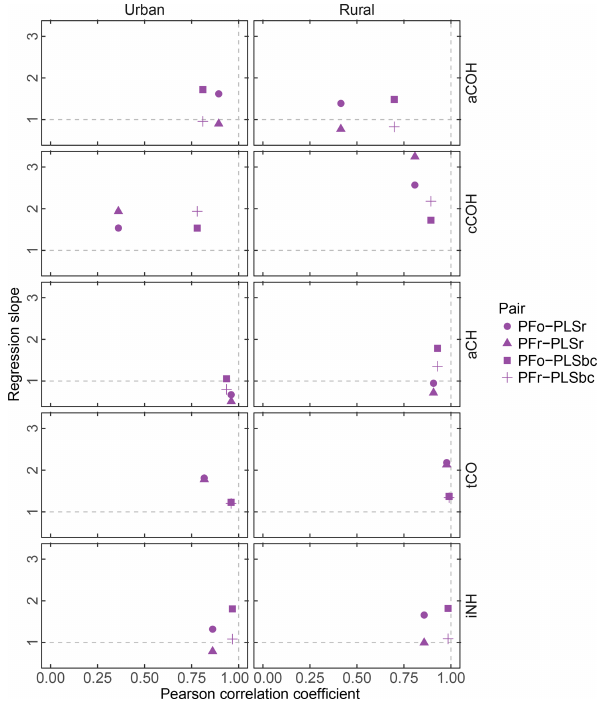
Figure 7. FG comparison summary. Pearson correlation coefficient PFo refers to peak fitting using the original parameters. PLSr refers to partial least square using raw spectra. PFr refers to peak fitting using the recalibrated absorption coefficients. PLSbc refers to par- tial least square using baseline-corrected